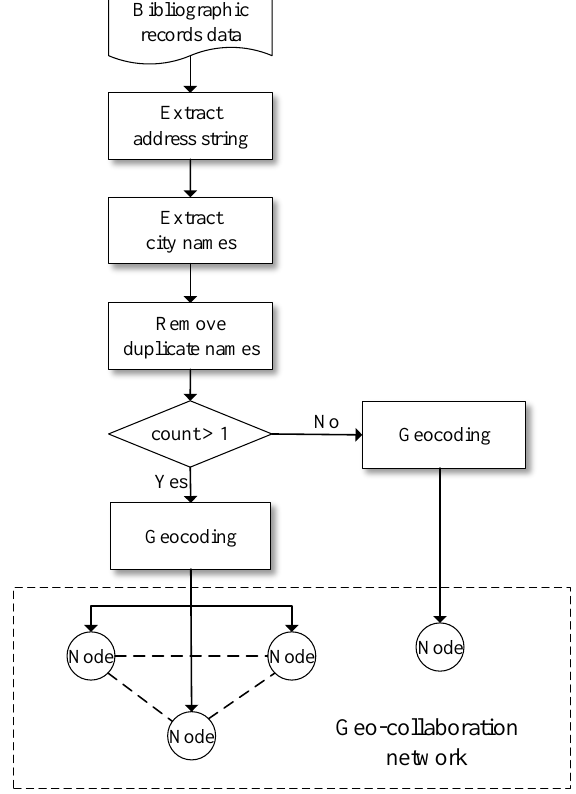
Figure 2. Process of constructing a geo-collaboration network.